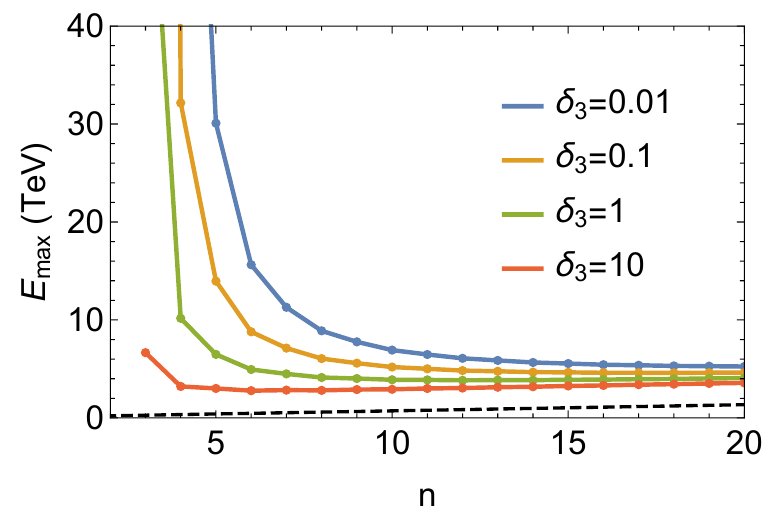
Figure 2 . The unitarity violating scale for the interaction Z 2 ferent values of (cid:14) 3